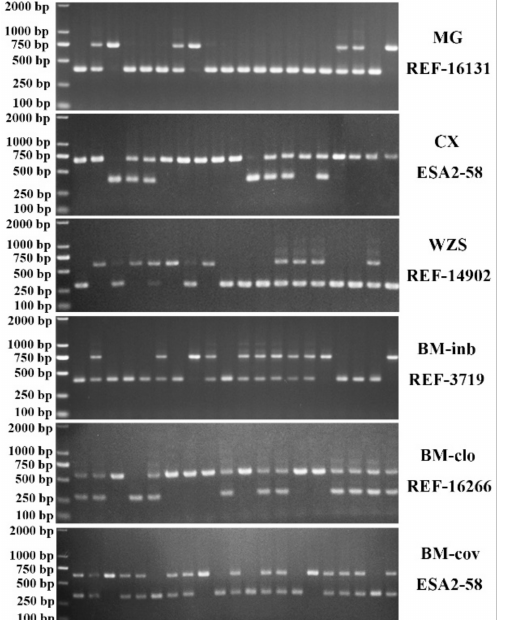
Figure 2. A representative electropherogram of SINE RIPs used for detection in the pig populations. MG: Mingguang small ear pig, WZS: Wuzhishan pig, CX: Congjiang Xiang pig, BM-clo, BM-inb, and BM-cov are three subpopulations of Bama pigs, kept in the national conservation farm (BM-cov), a closed herd (BM-clo) and a highly inbred line (BM-inb) in Guangxi University. REF-16131, ESA2-58, REF-14902, REF-3719, REF-16266 were SINE RIP